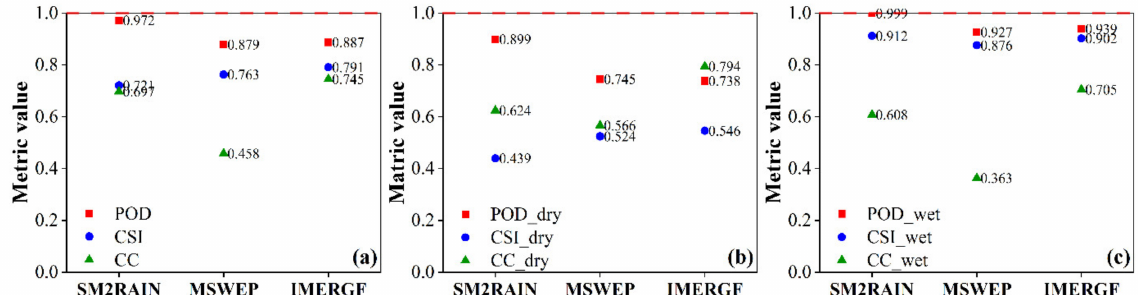
Figure 6. Rainfall performance metrics POD, CSI, and CC for ( a ) annual, ( b ) dry, and ( c ) wet seasons. The red dashed line shows the best value.